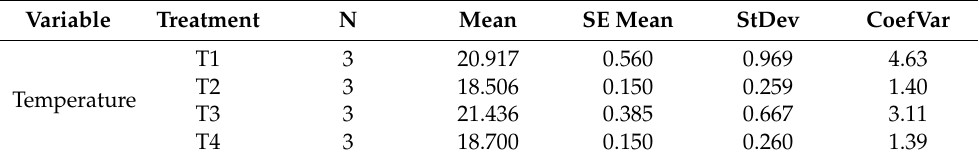
Table 7. Basic statistics for the variable “soil temperature.” T1: without mulch + 251 mm of water; T2: with mulch + 251 mm of water; T3 without mulch + 129 mm of water; T4: with mulch + 129 mm of water. Variable Treatment N